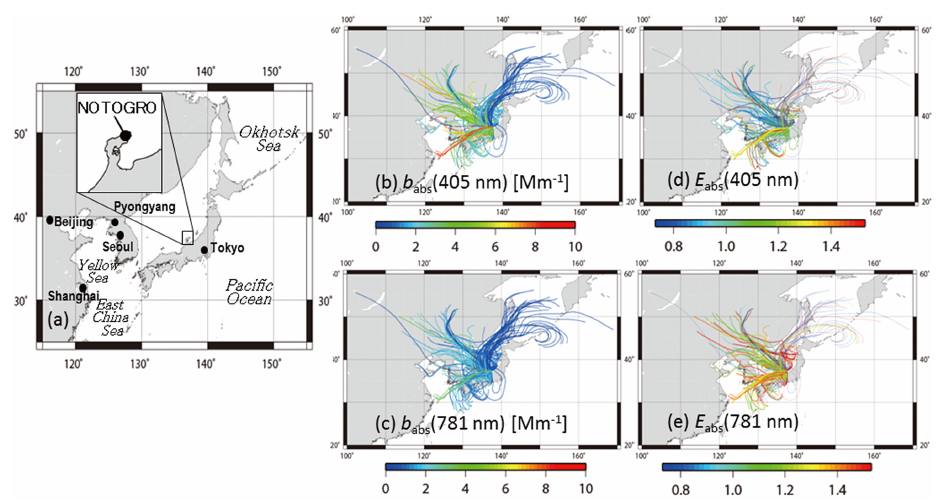
Figure 3. (a) Location of NOTOGRO in Ishikawa, Japan, and (b–e) 72h backward air trajectories for air masses reaching the observation site at 500m a.s.l. These are colored with (b) b abs (405nm), (c) b abs (781nm), (d) E abs (405nm), and (e) E abs (781nm). The trajectories for E abs calculated from b abs data below the detection limit are represented as thin lines in (d) and (e)